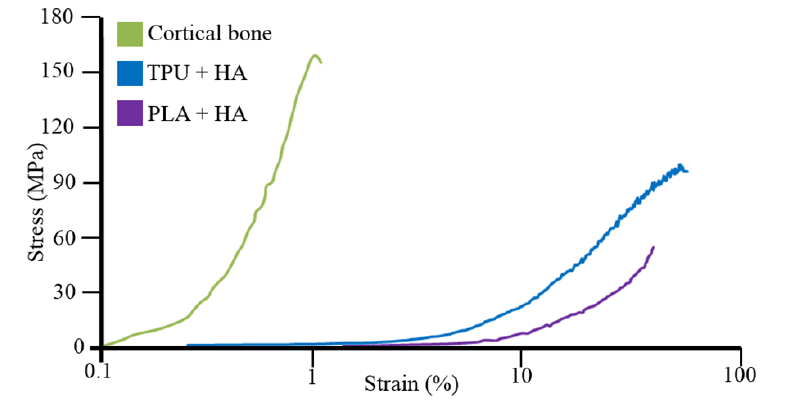
Figure 9. Compression curves of cortical bone, TPU-based materials obtained at 215 ◦ C, 60’ of exposure, and 2.5 × 10 − 4 MPa pressing force with HA particles embedded and PL- based materials obtained at 205 ◦ C, an exposure time of 60’, and a maximum pressing force of 0.5 × 10 − 4 MPa.